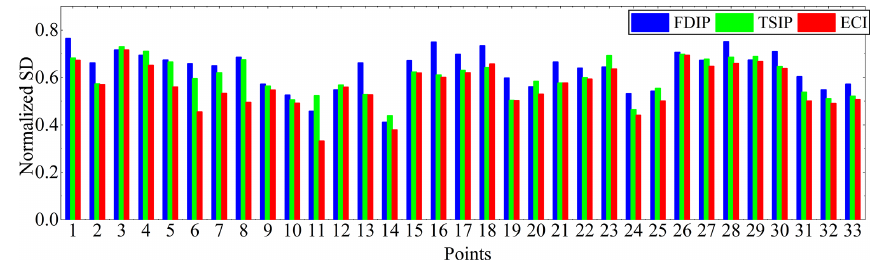
Figure 13. Standard deviation (SD) values of the ECI algorithm and the others compared to the data dots from 18 to 50 at